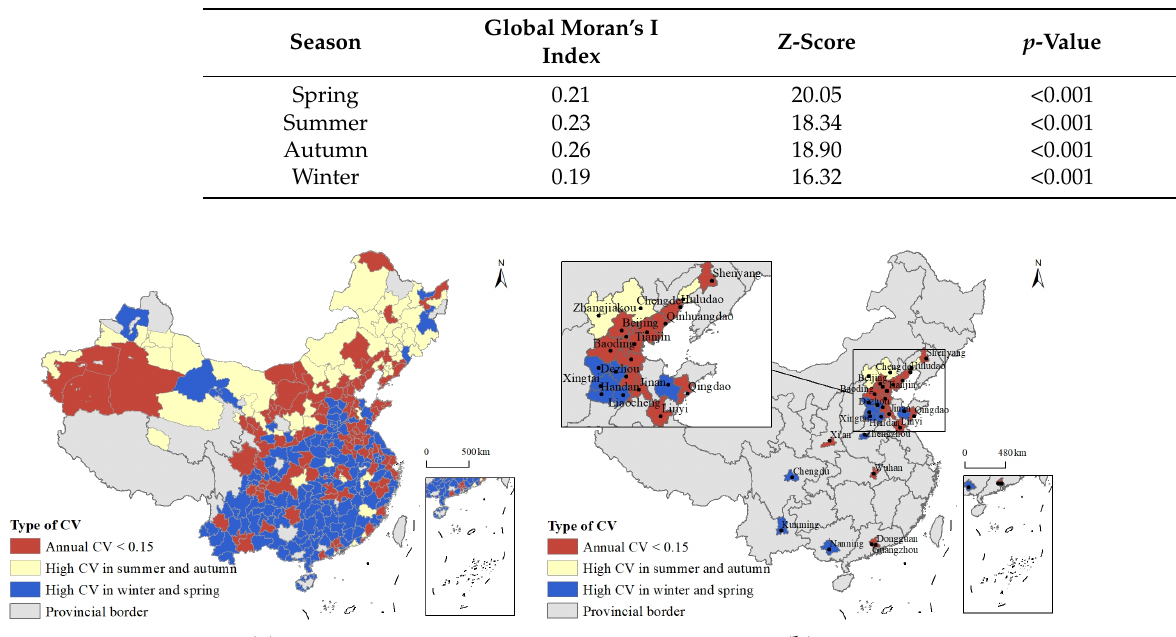
Table 4. Global Moran’s I of spatial distribution of city importance.